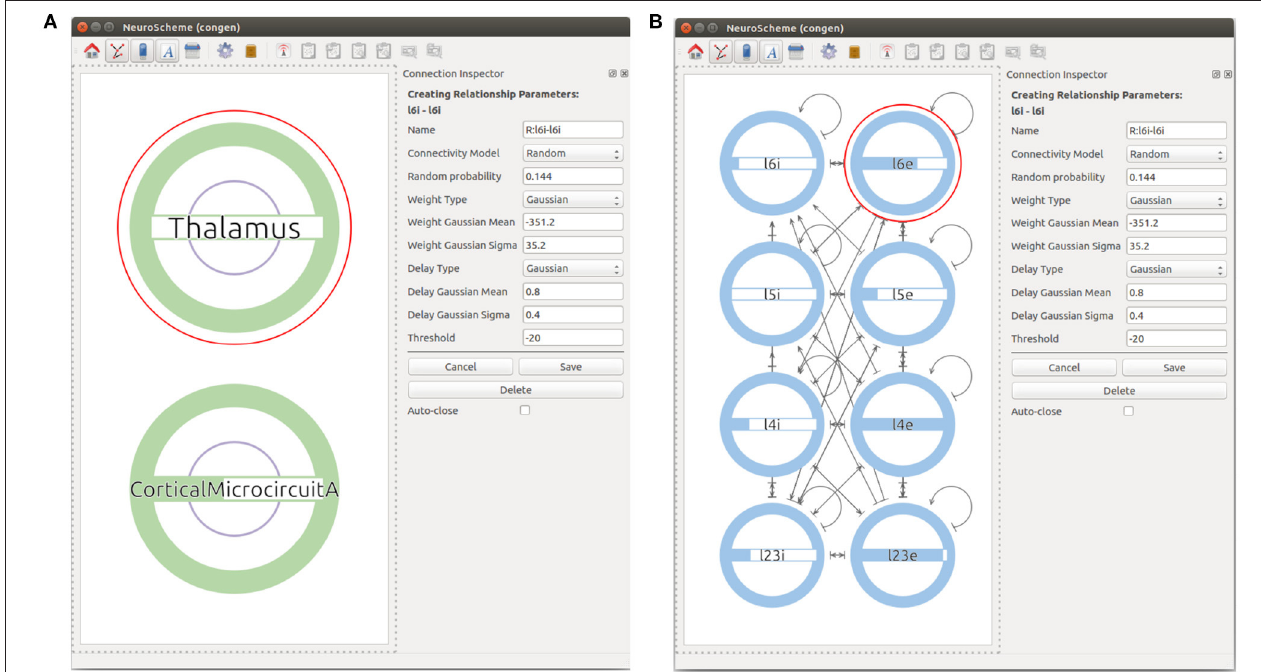
FIGURE 6 | Views at different levels of cortical microcircuits. Panel (A) shows microcircuit super-population and the Thalamic super-population. Panel (B) presents the microcircuit super-population where all 8 populations can be seen with their respective